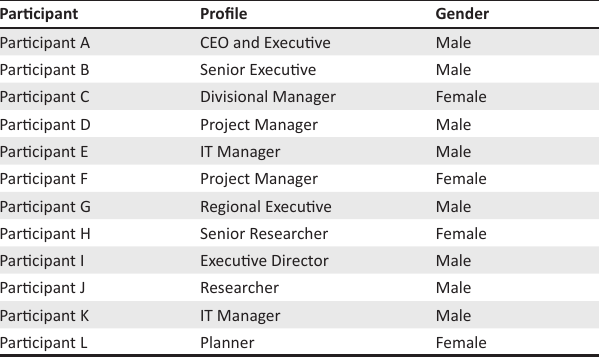
TABLE 1a: Profiles of research participants. Participant